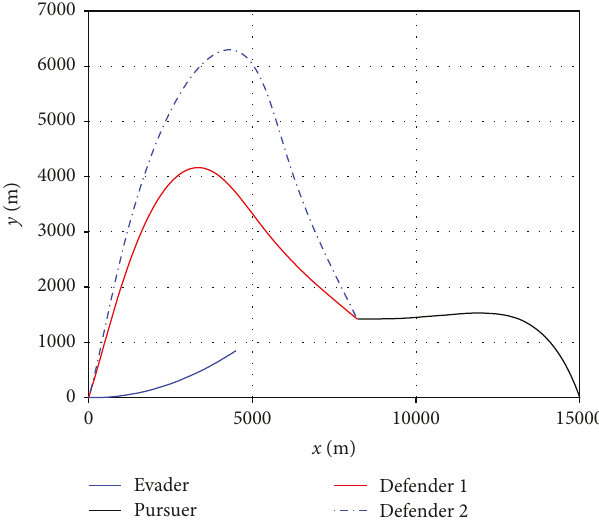
Figure 11: LOS angle rotation rate variation.